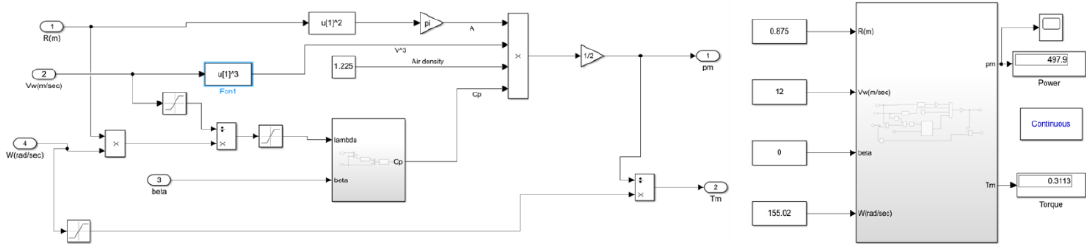
Figure 15. Simulation of the power and torque of the selected wind turbine.